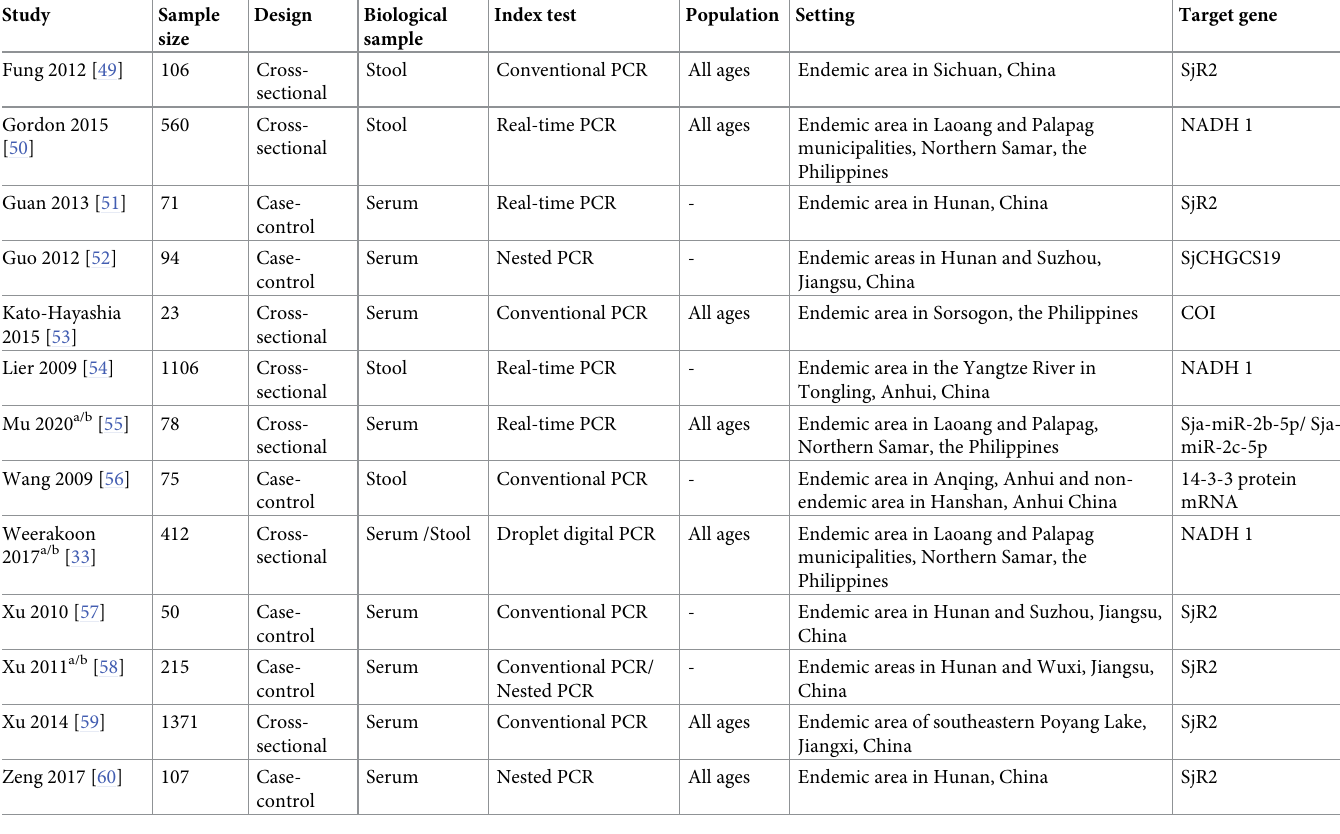
Table 1. Characteristics of the eligible publications included in the analysis.